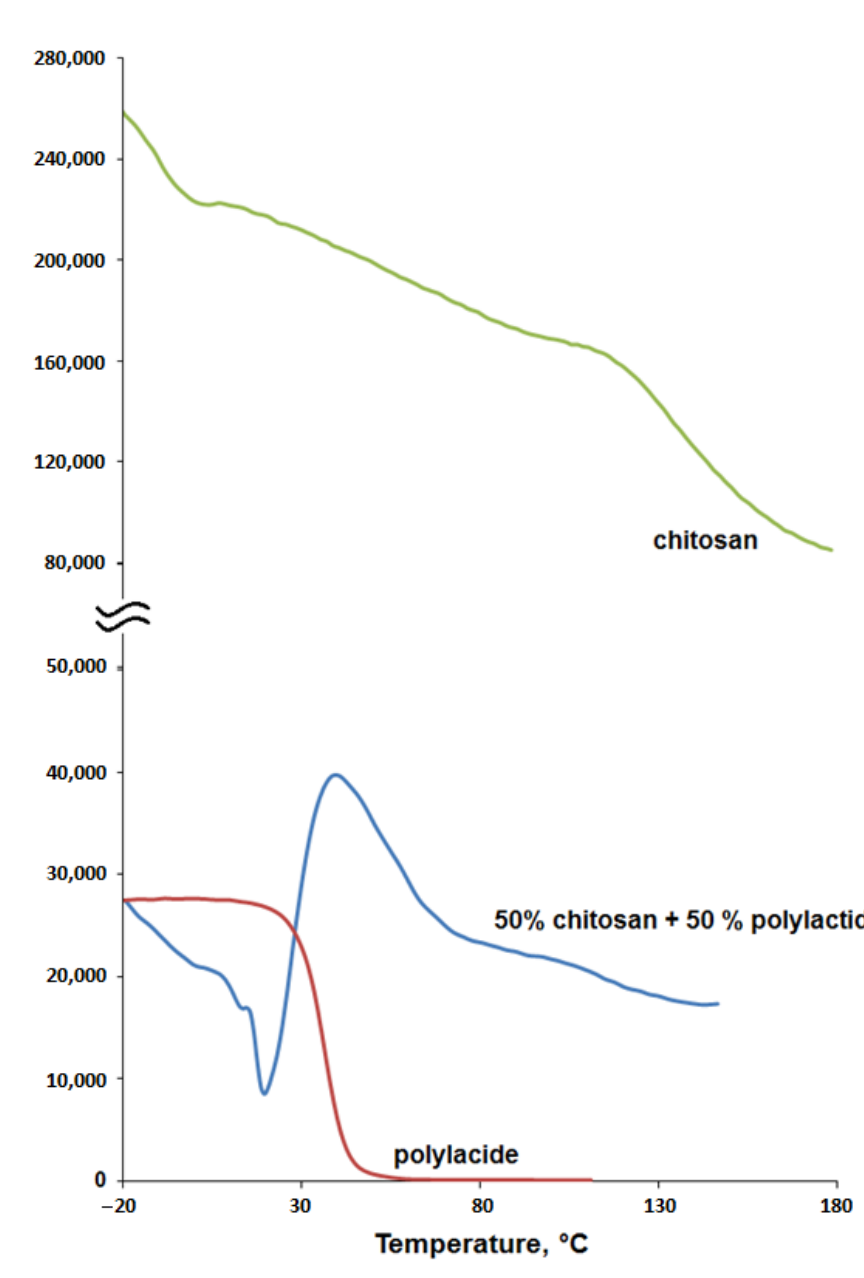
Figure 4. Dynamic mechanical analysis of samples. Figure 4 The high strength characteristics of the chitosan-polylactide composition are appar- ently due to a change in the structure of chitosan in a mixture with polylactide, which is confirmed by X-ray phase analysis data (Figure